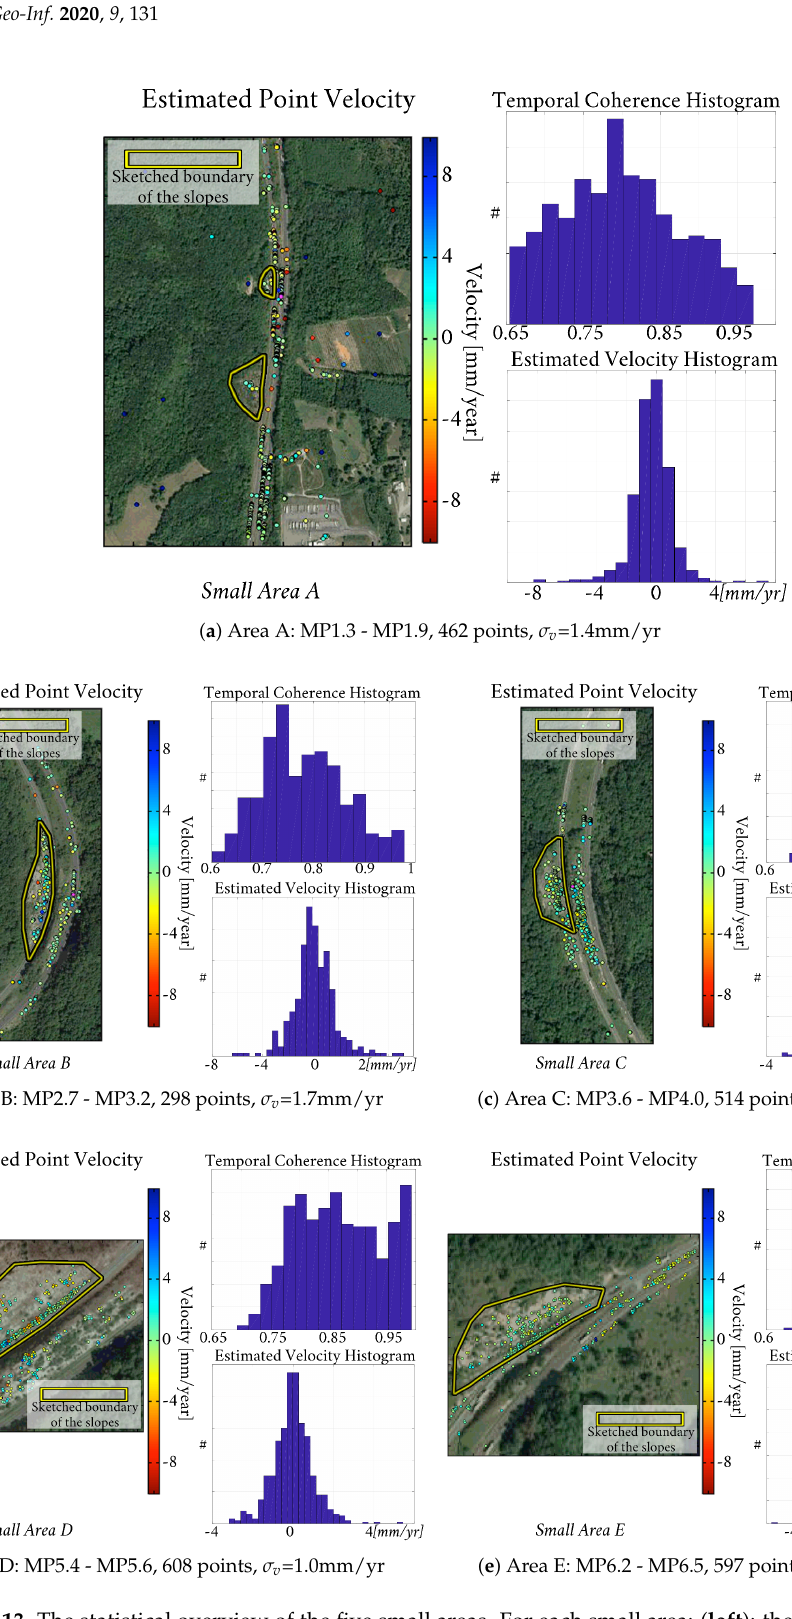
Figure 13. The statistical overview of the five small areas. For each small area: ( left ): the displacement velocity of selected points geocoded to Google Earth imagery; ( top right ): histogram of temporal coherence; ( bottom right ): histogram of estimated velocity. The overall standard deviations of velocity ( σ v ) are mostly close to 1 mm/yr, suggesting no significant deformation trend on the